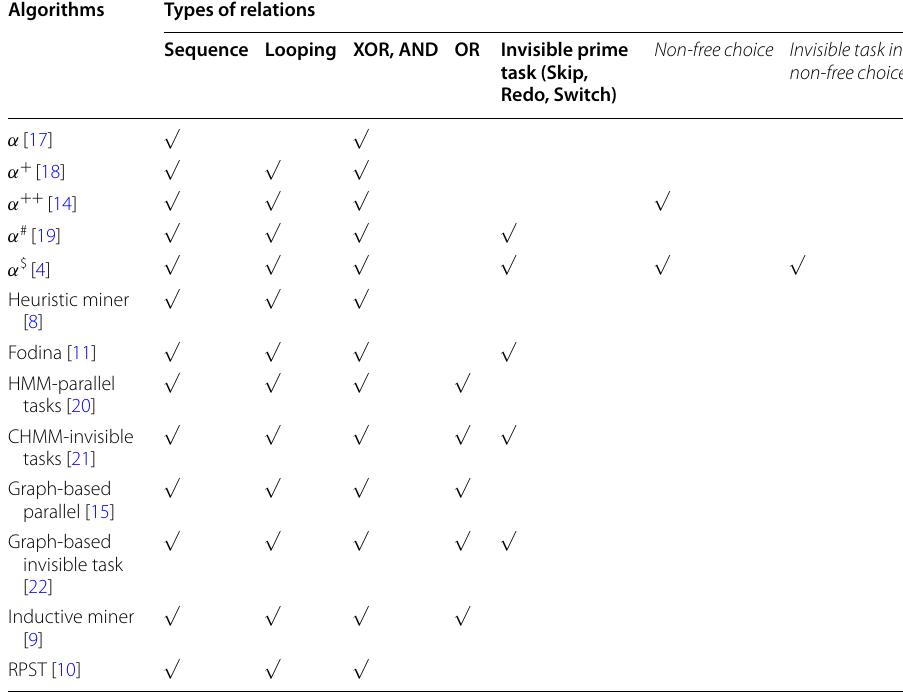
Table 1 Algorithms of process discovery Algorithms Types of